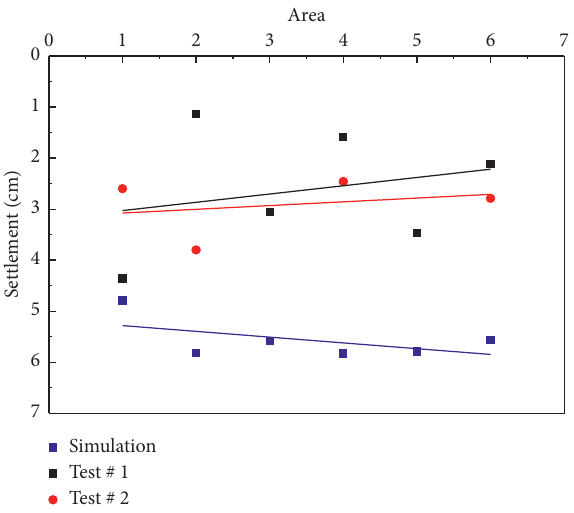
Figure 5: Numerical analysis results at 200kPa.